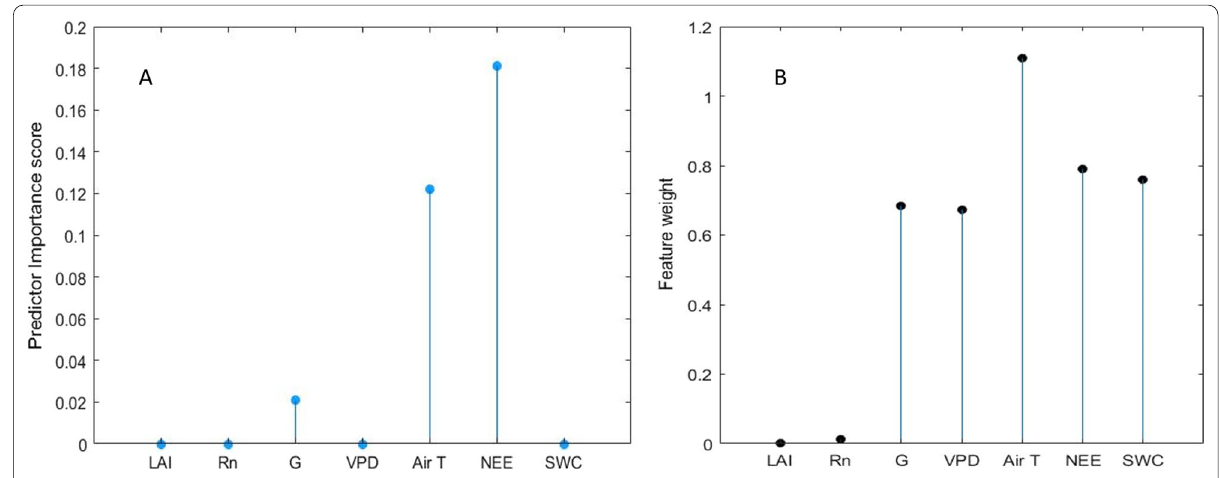
Fig. 3 Results of the feature selection analysis by NCA and MRMR algorithms